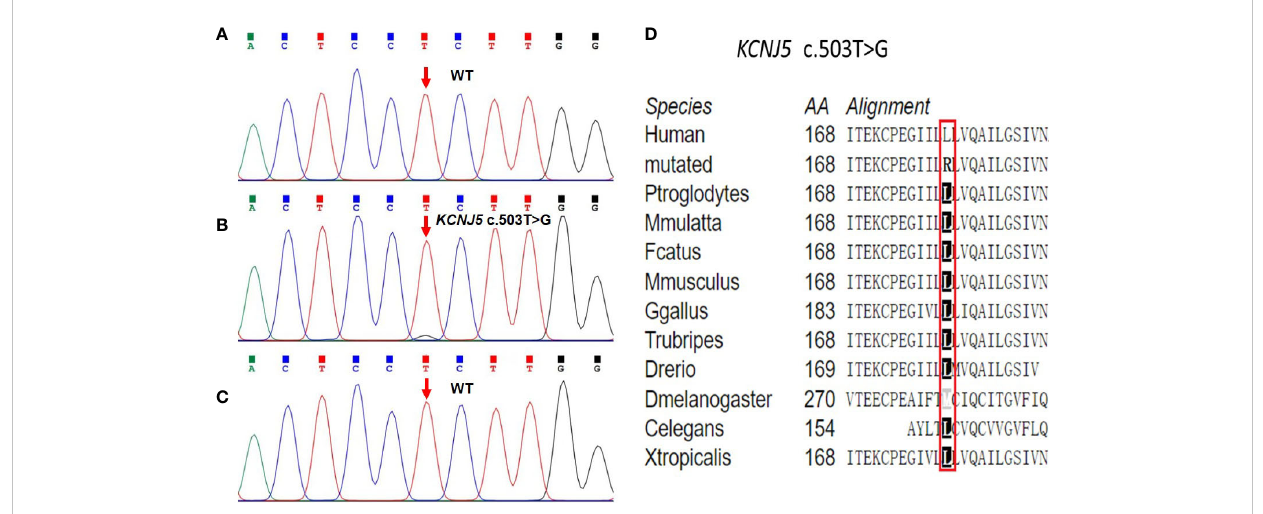
FIGURE 4 Sequencing chromatograms of the KCNJ5 variant identi fi ed in peripheral blood samples and bilateral adenomas. (A) The germline KCNJ5 variant was not found in peripheral blood samples. (B) Heterozygous KCNJ5 c.503T > G somatic variant was identi fi ed in the left adenoma. (C) Normal sequence of the KCNJ5 gene in the right adenoma. (D) Multiple alignment of the KCNJ5 protein sequence in different species, indicating conservation of the residues KCNJ5 c.503T > G affected by this